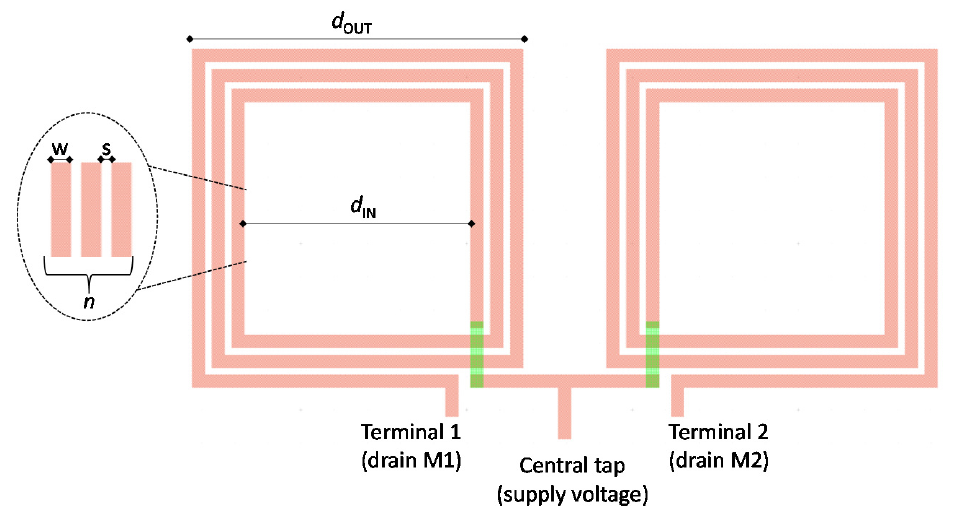
Figure 10. Micro-antenna U-shape configuration for D -class oscillator.